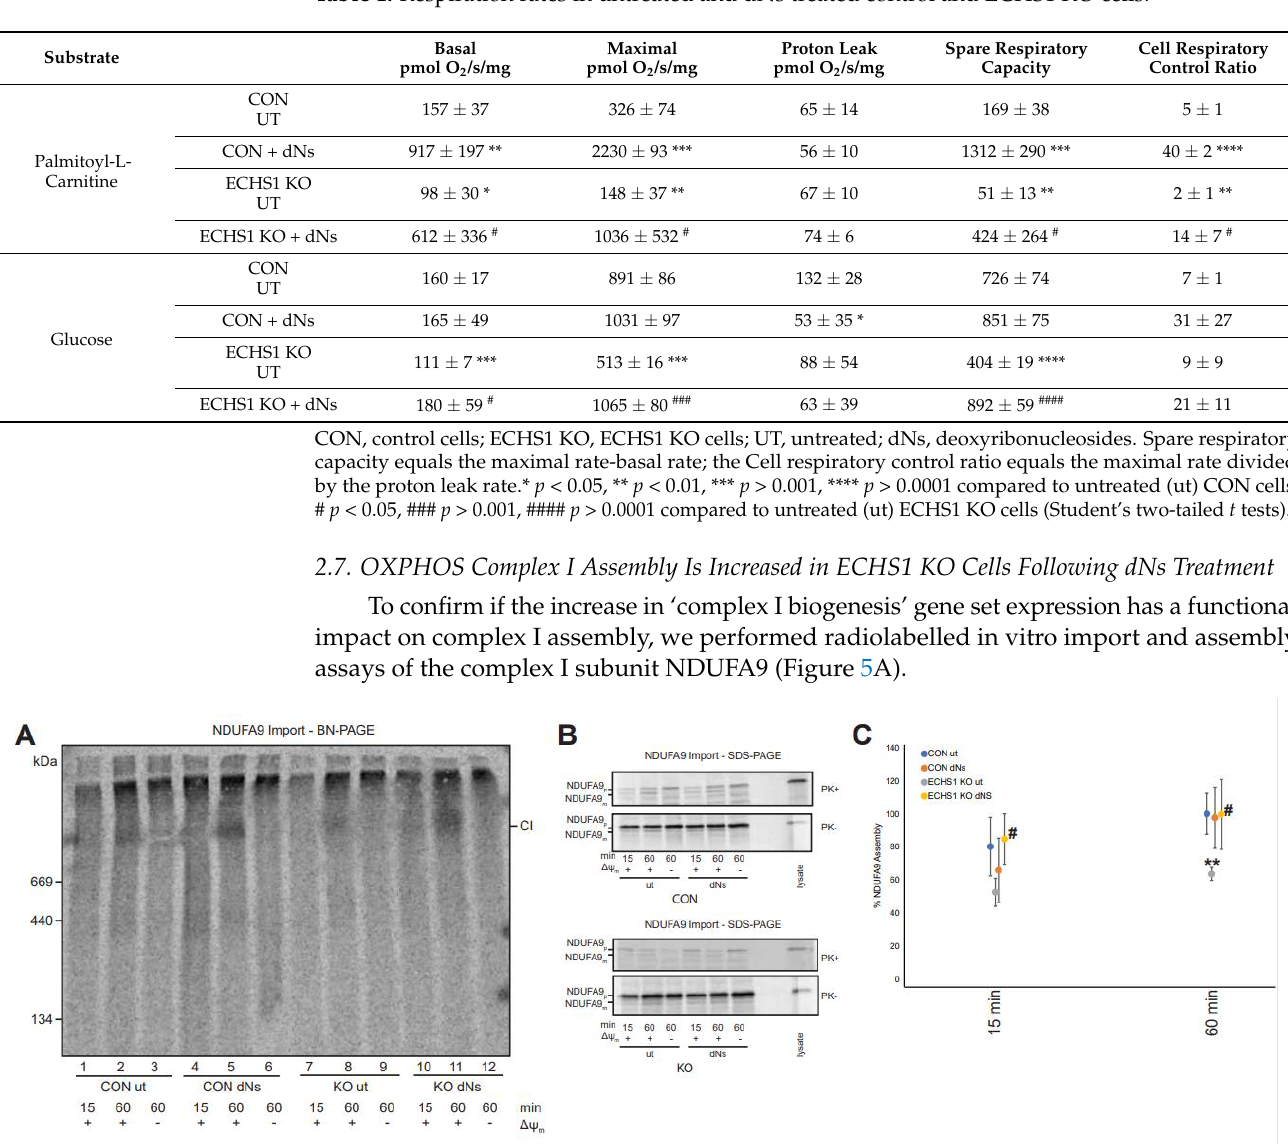
Table 1. Respiration rates in untreated and dNs treated control and ECHS1 KO cells.